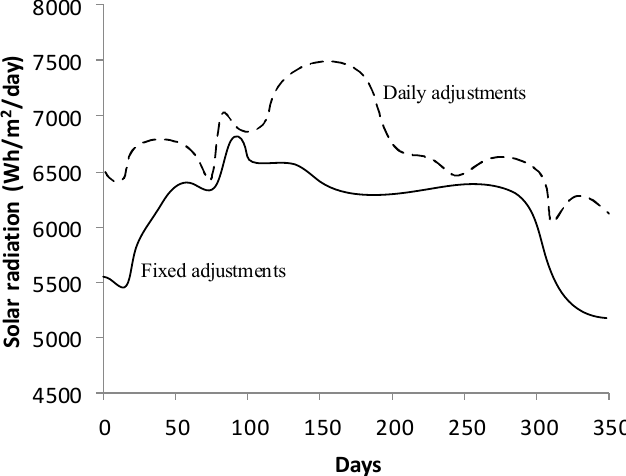
Figure 7. Daily solar radiation on fixed and daily adjusted surfaces [45].